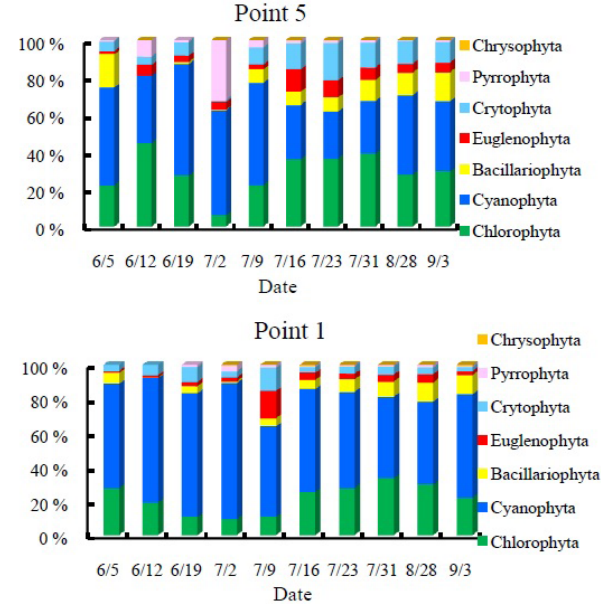
Figure 9. Changes in each phytoplankton species’ proportion at Point 1 and Point 5.